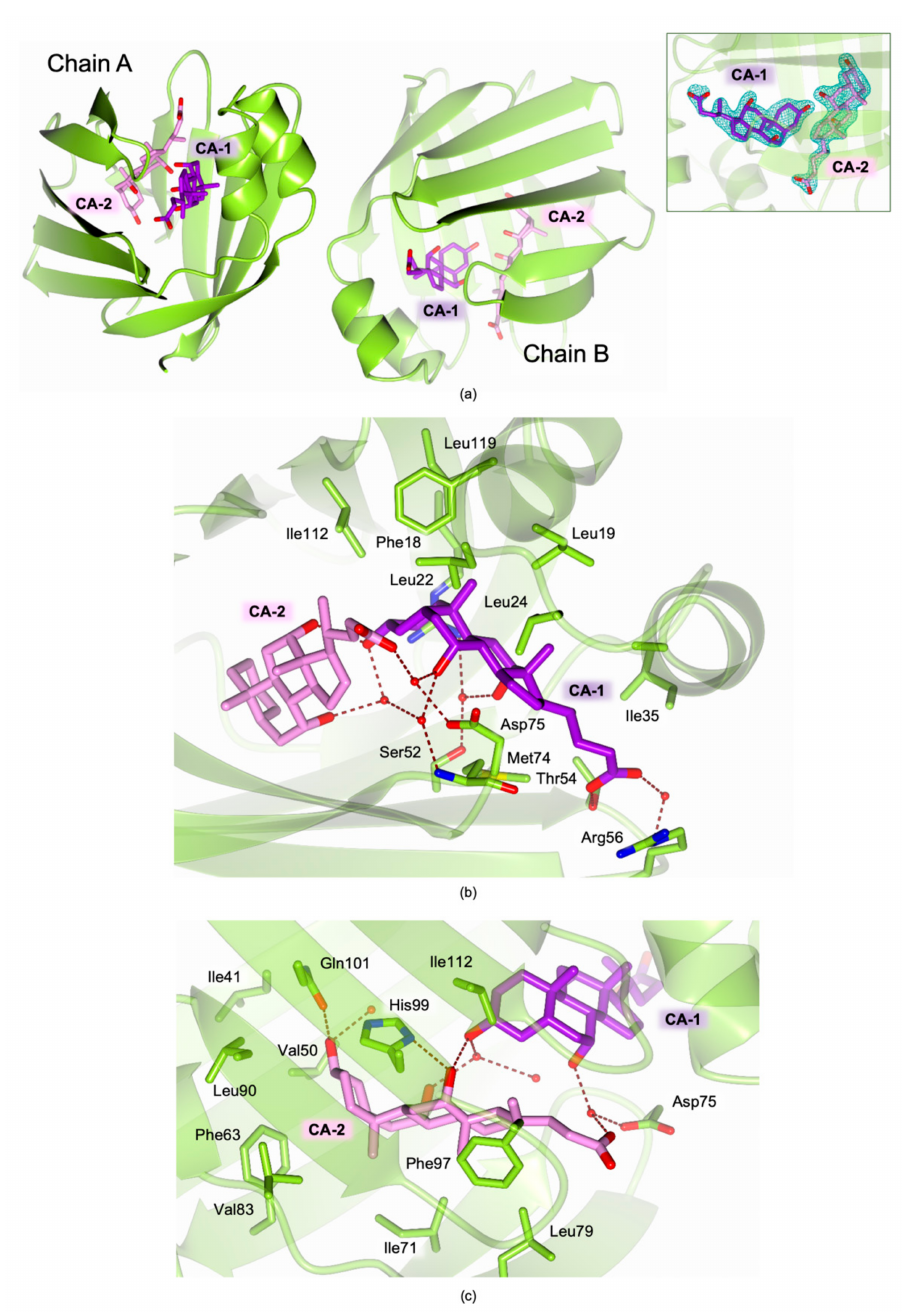
Figure 6. Crystal structure of recombinant cL-BABP (green-yellow cartoon and carbons) in complex with CA. The inner cavity of the protein is populated by two CA molecules, named CA-1 (violet carbons) and CA-2 (pink carbons). ( a ) Cartoon representation of the two cL-BABP chains found in the crystal asymmetric unit. The fitting of the CA molecules in the omit map (teal mash, contoured at the 3.0 σ level) is shown in the inset. ( b , c ) Ligand cavity view of ( b ) CA-1 populating the cL-BABP site 1 and ( c ) CA-2 populating the cL-BABP site 2. In all figures, water molecules are displayed as red spheres; sulfur atoms are colored